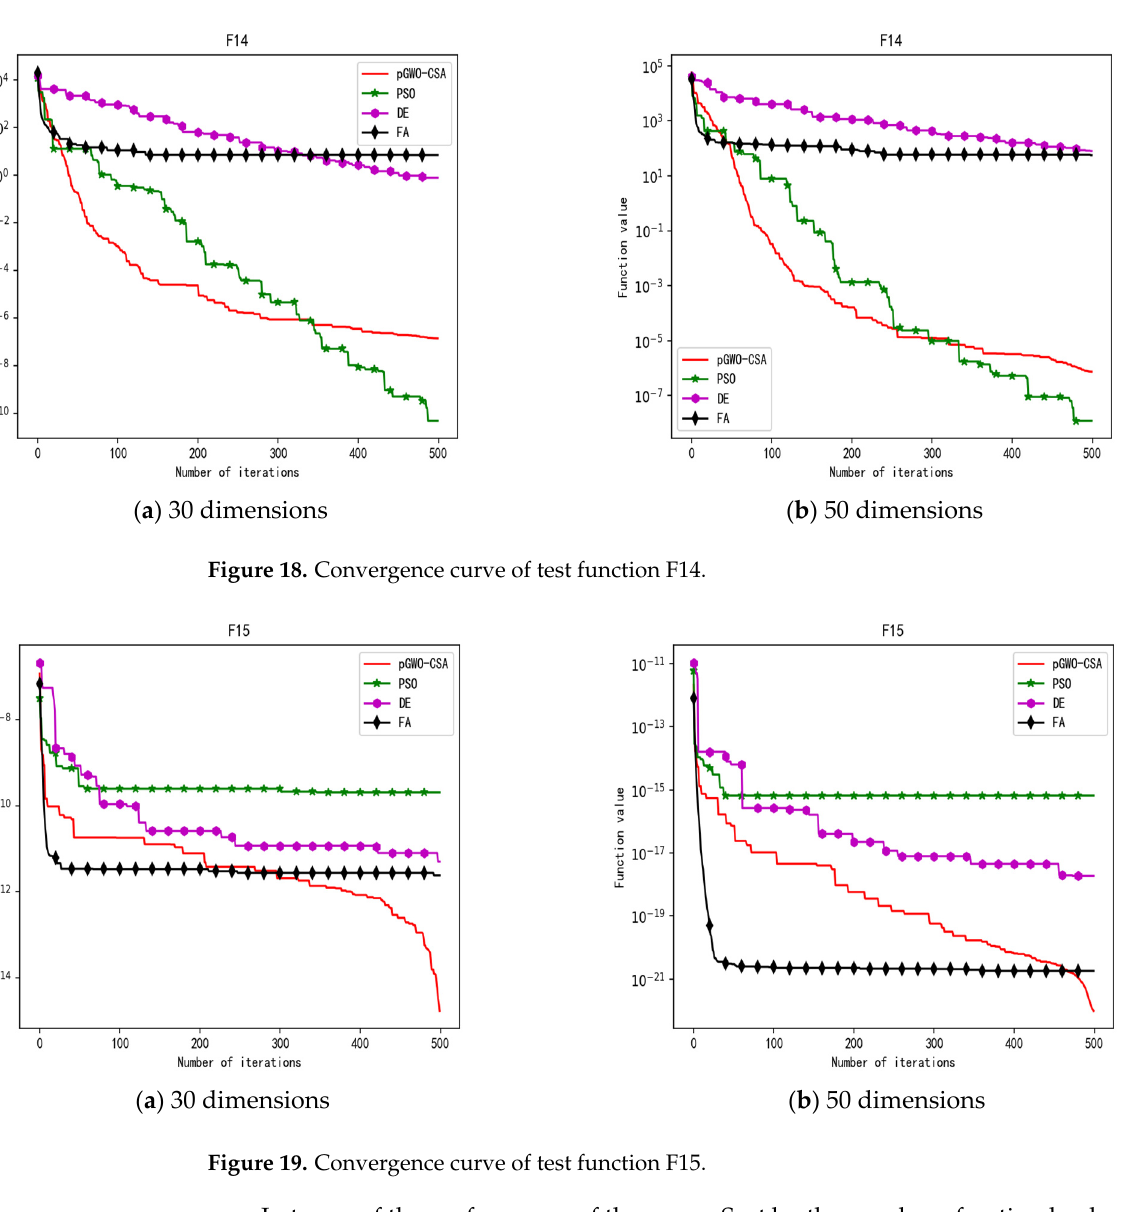
Figure 17. Convergence curve of test function F13.